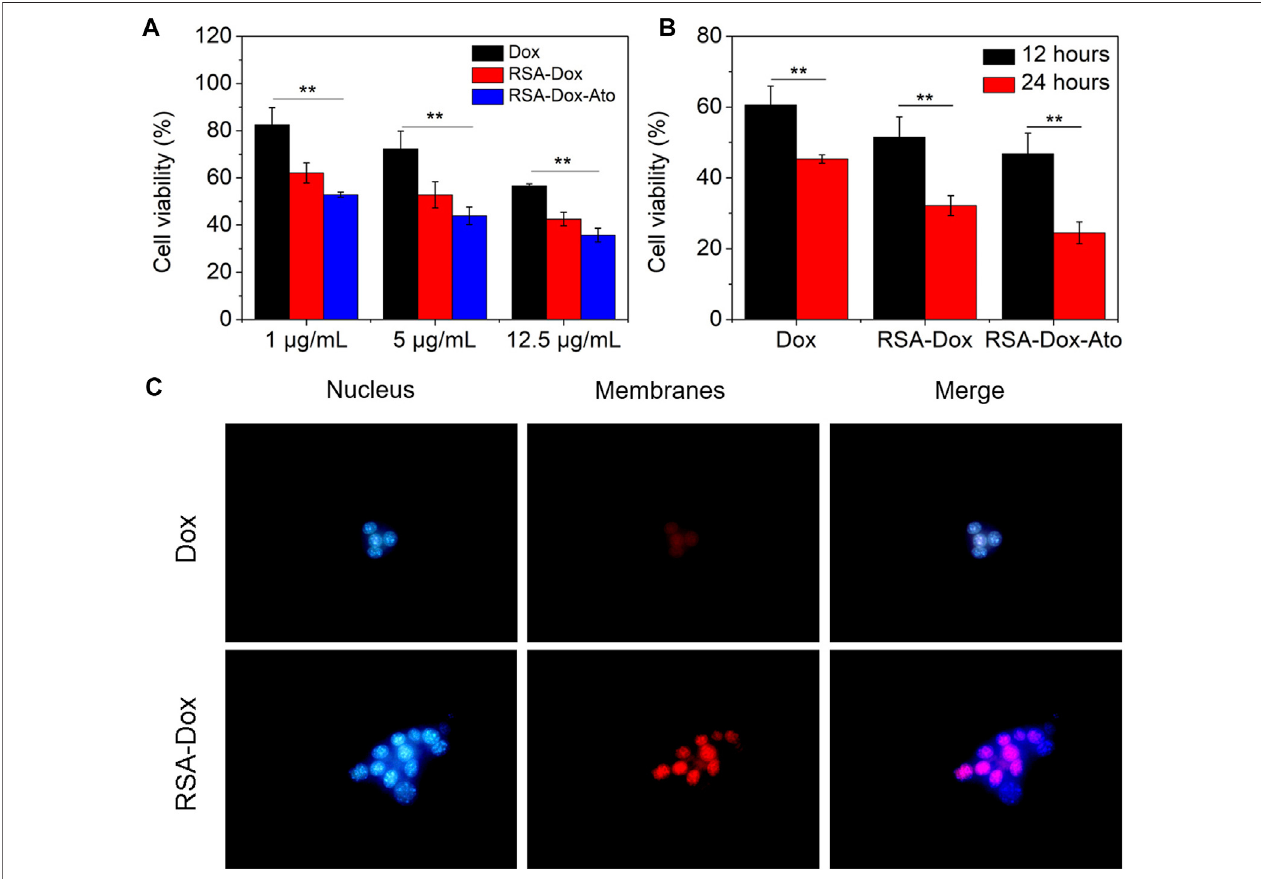
FIGURE 2 | The cell cytotoxicity and endocytosis were evaluated in vitro . (A) The cell cytotoxicity of 4T1 cells in a dose-dependent manner was recorded by MTT assay invitro (Dox,RSA-Dox,RSA-Dox-Ato). (B) Thecellcytotoxicityof4T1cellsinatime-dependentmannerwasrecordedbyMTTassay invitro (Dox,RSA-Dox,RSA- Dox-Ato). (C) The endocytosis of 4T1 cells was observed by microscope with a ×40 objective in vitro . ( n = 5, p p < 0.05, pp p < 0.01).